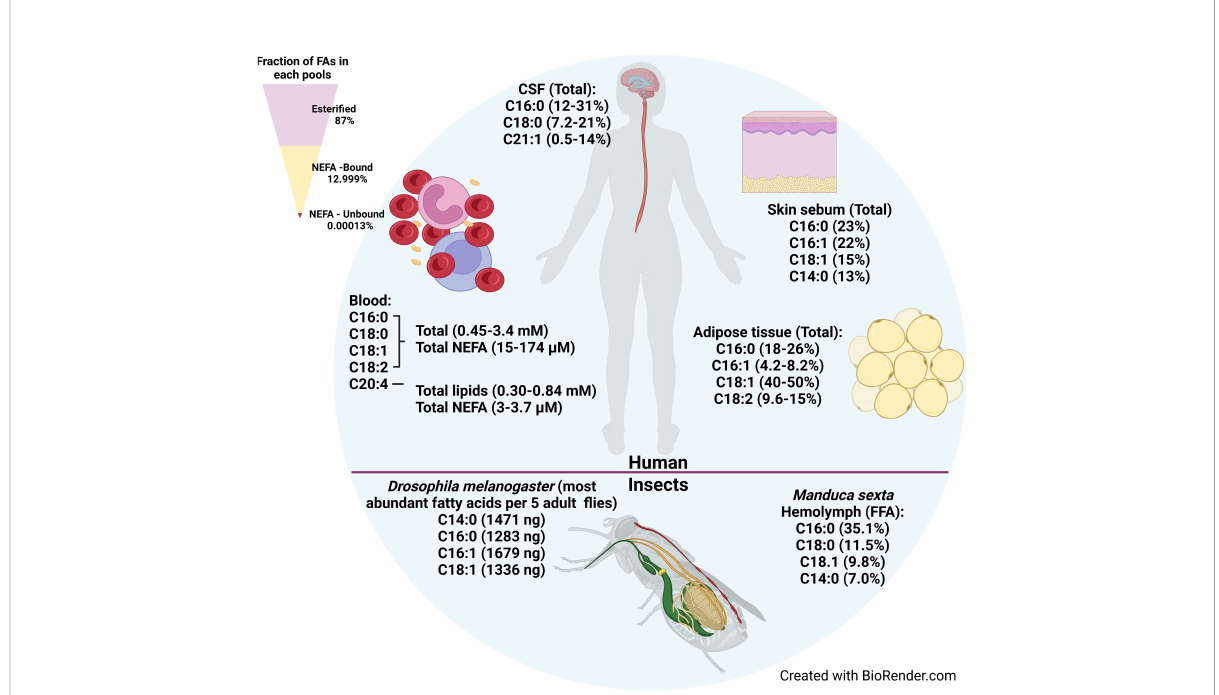
FIGURE 1 Fatty acid availability in human tissues, hemolymph, and insect bodies. The most abundant fatty acids available in various tissues where T. brucei harbors in human body are shown on upper portion. The most abundant fatty acids in the whole body of Drosophila melanogaster (fruit fl y) and the most abundant fatty acids available in hemolymph of Manduca sexta (moth) are shown in the bottom portion. The fatty acids availability in tsetse fl y was not found in the literature. Upper left triangle shows relative proportion in serum of esteri fi ed fatty acids, and the bound and unbound fractions of non-esteri fi ed fatty